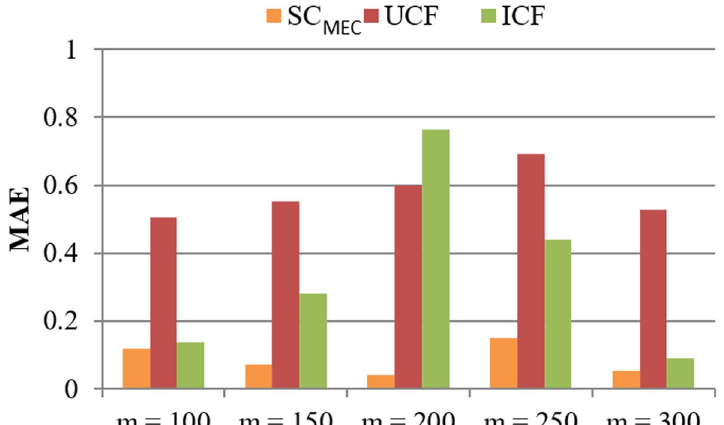
Fig. 4 Accuracy comparison (w.r.t. m